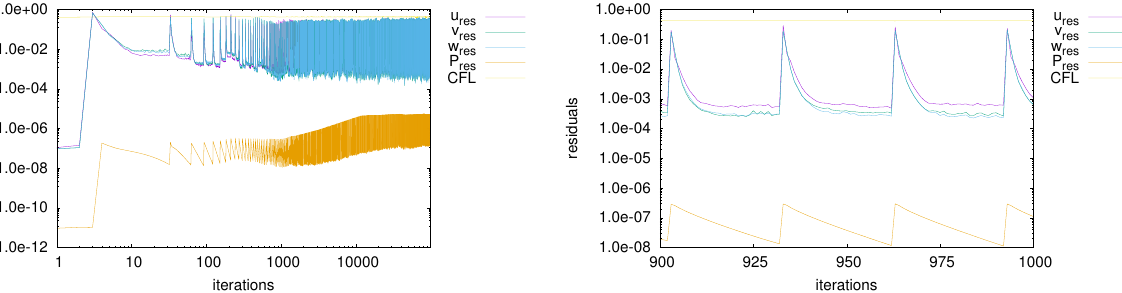
Figure 6. Residuals of velocity components and pressure, CFL condition during iteration on physical time and pseudo-time loops ( left ). Details of pseudo-time loop iteration ( right ).